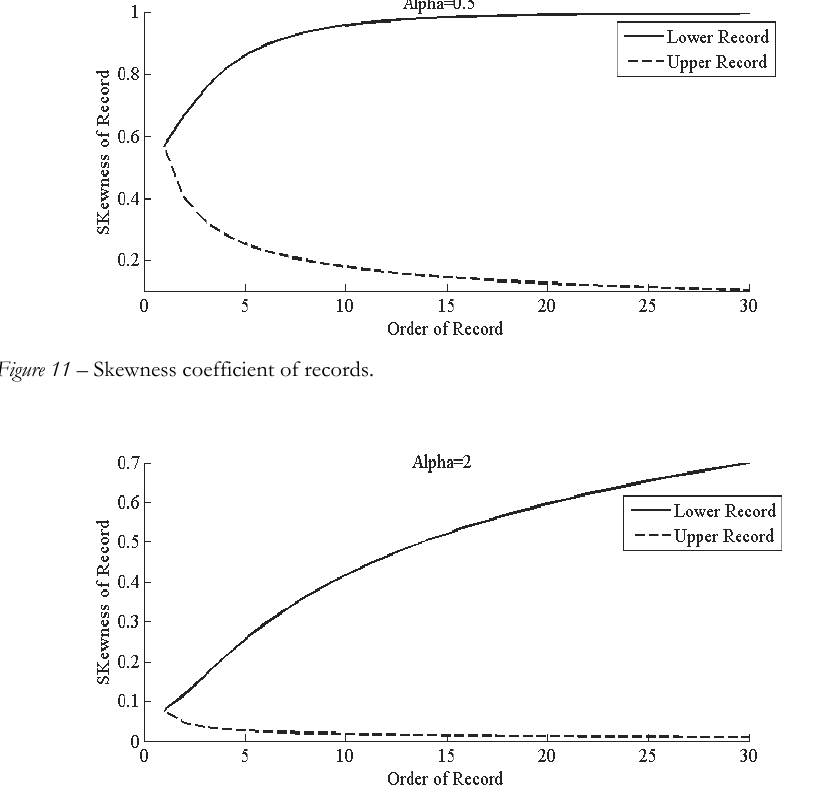
Figure 12 – Skewness coefficient of